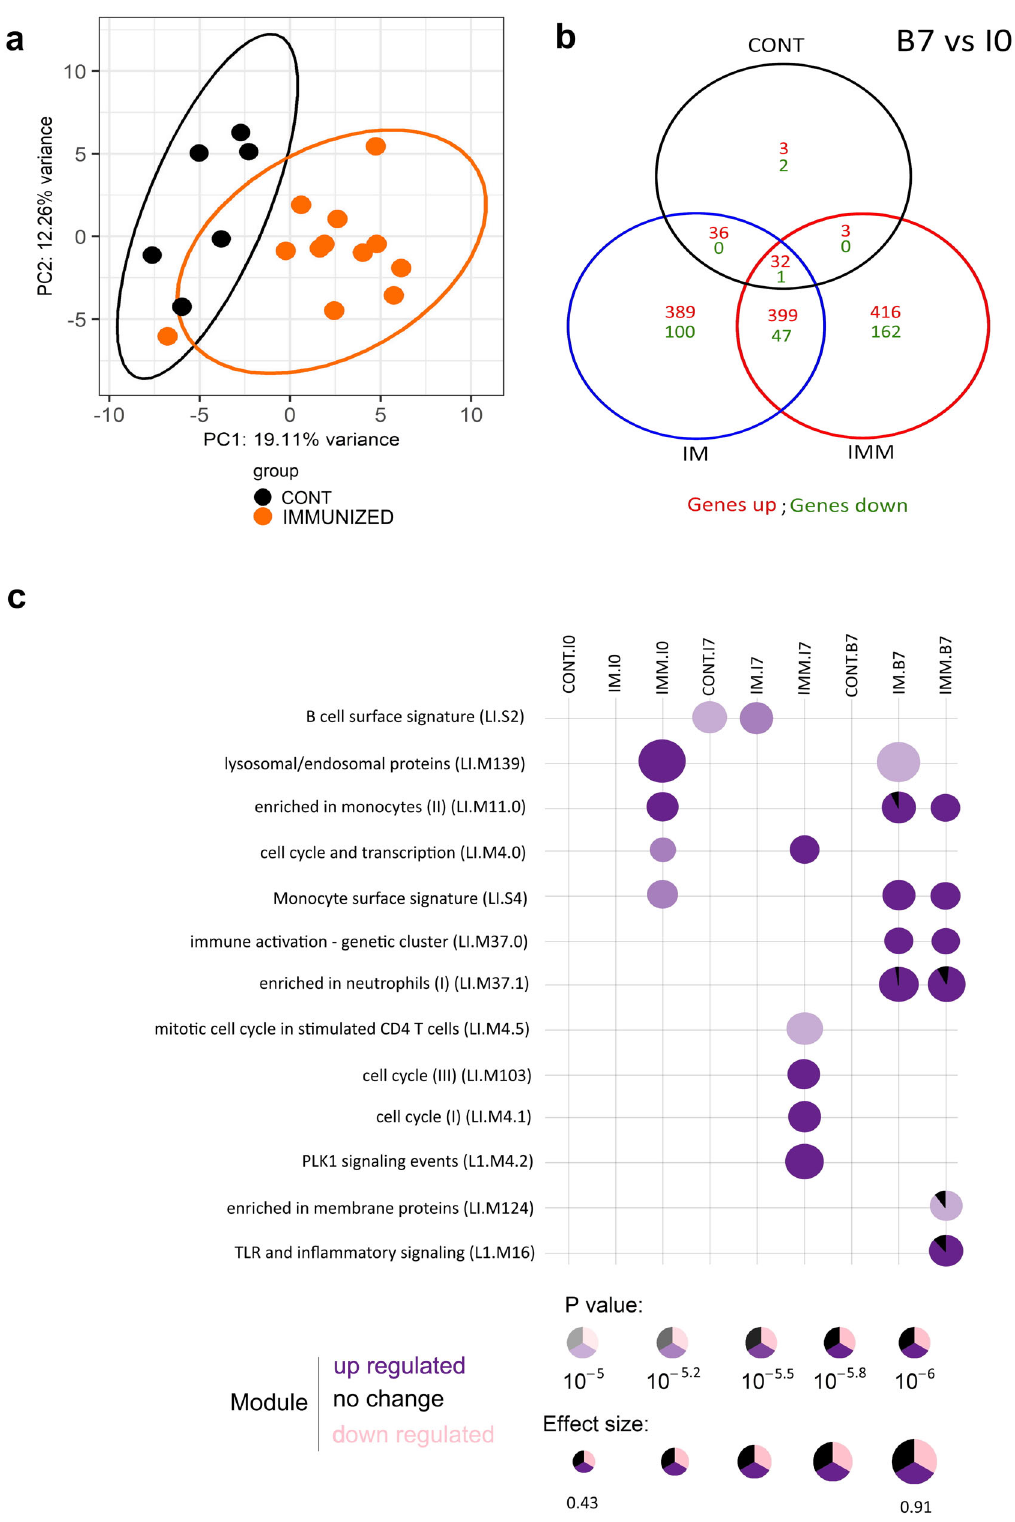
Fig. 4 Whole-blood transcriptomic response to immunization in control and immunized groups. a A principal component analysis (PCA) on the top 500 most DEG of CONT (black) and immunized IM + IMM (orange) cows after the fi rst injection (I7) shows that the expression pro fi le of blood cells changes upon systemic immunization. b Venn diagram of identi fi ed genes in control, intramuscular and intramammary groups at 7 days after booster injection (B7) compared to I0 (before immunization). c A modular analysis on B7 gene expression shows the signi fi cant difference ( p value < 10 − 5 ) of upregulated biological functions between CONT, IM, and IMM